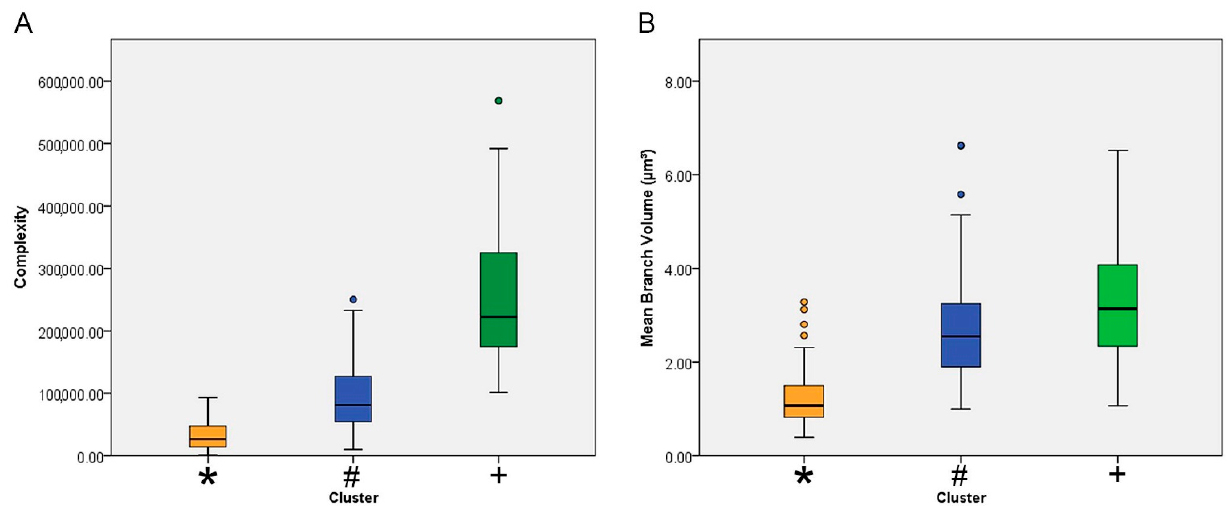
Figure 4. Mean values and corresponding errors (box edges) and standard deviations (whiskers) for the complexity ( A ) and the average volume of the microglia branches ( B ) of clusters 1 (blue/#) and 2 (green/+), both representing microglia from infected animals, and for control animal microglia (cluster 3, orange/*). Note that control animal microglia were less complex and exhibited thinner branches than the microglia of infected animals.